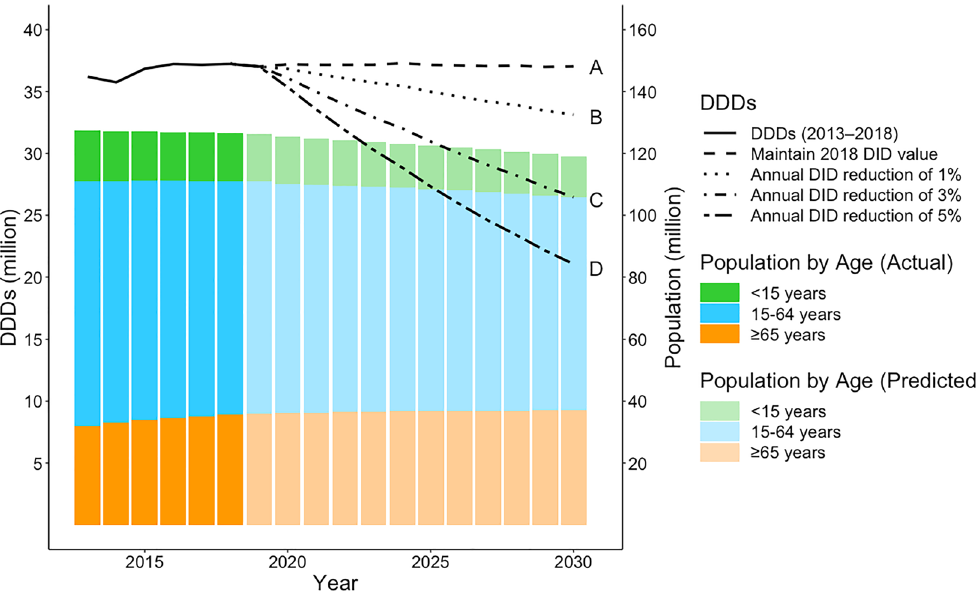
Figure 3. Scenario analysis of trends and predictions in the DDDs of parenteral antimicrobials according to annual DID reduction rate. Solid lines represent chronological data of DDDs. The dashed line A represents the predicted changes if DID maintains the 2018 value. The dotted line B represents the predicted changes if DID is decreased by 1% annually. The dash-dotted line C represents the predicted changes if DID is decreased by 3% annually. The dash- dotted line D represents the predicted changes if DID is decreased by 5% annually. The dark bars represent the actual population numbers, and the light bars represent the predicted population numbers. The population numbers are of the Japanese population 13,14 . DDD, defined daily dose; DID, defined daily doses/1000 inhabitants/day.